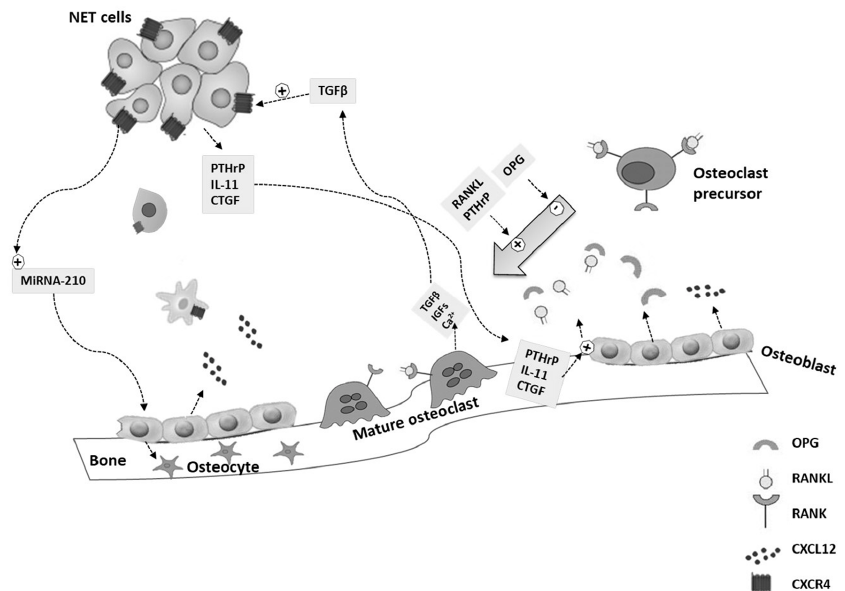
Figure 1. Molecular mechanism of bone metastasis in neuroendocrine neoplasms: the “vicious cycle”. Neuroendocrine neoplasms (NENs) cells secrete pro-osteolytic factors, including the parathyroid hormone-related protein (PTHrP), interleukin-11 (IL-11), and the connective tissue growth factor (CTGF), which stimulate the activator receptor of the nuclear factor-kappa B ligand (RANKL) production by osteoblasts and/or the decrease of osteoprotegerin (OPG) within the bone stroma. Thus, RANKL induces osteoclast formation. Osteoclastic bone resorption causes the release and activation of growth factors, including the transforming growth factor- β (TGF β ), the insulin-like growth factors 1 (IGF1), and calcium ions (Ca2+). TGF β can increase tumor production of the C-X-C motif receptor 4 (CXCR4) in NEN cells. The C-X-C motif chemokine-ligand-12 (CXCL12) is mainly produced by osteoblasts and can attract CXCR4-overexpressing NEN cells. CXCR4 and CTGF play a role in the migration of NEN cells to the bone. Micro-RNA (miRNA)-210 is upregulated in NEN cells and regulates the di ff erentiation of osteoblasts into